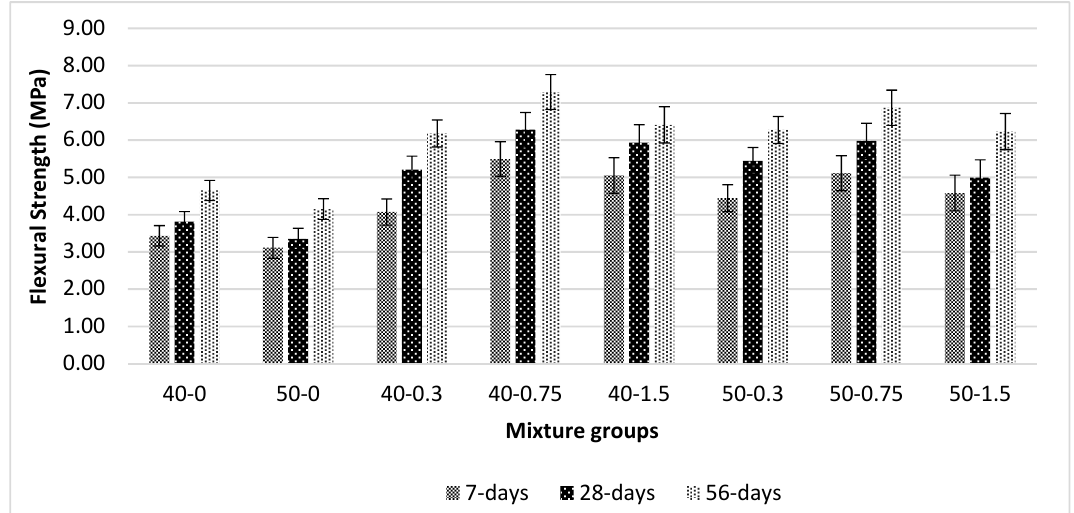
Figure 8. Flexural strength values for basalt-reinforced bottom ash cement paste composites at 7, 28 and 56 days of curing.